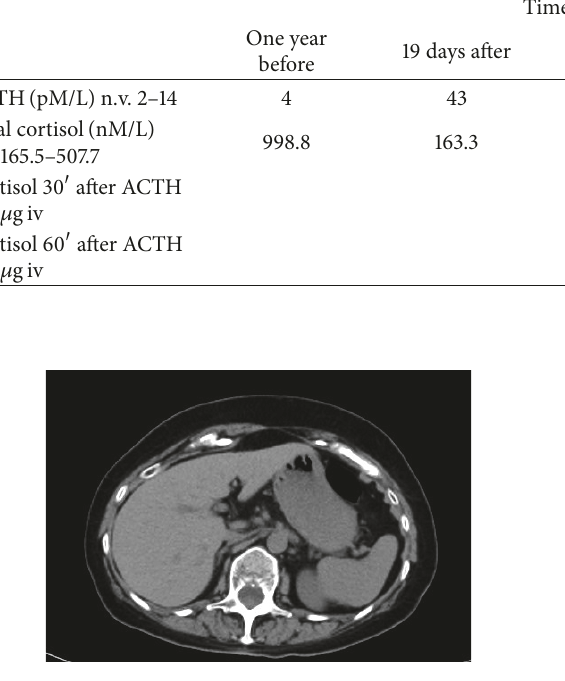
Figure 2: Abdomen CT showing adrenal glands normalized in volume 6 months